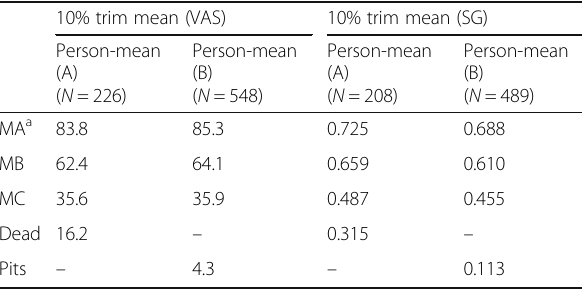
Table 1 Basic socio-demographic characteristics of the Table 2 Scores for three marker states in two